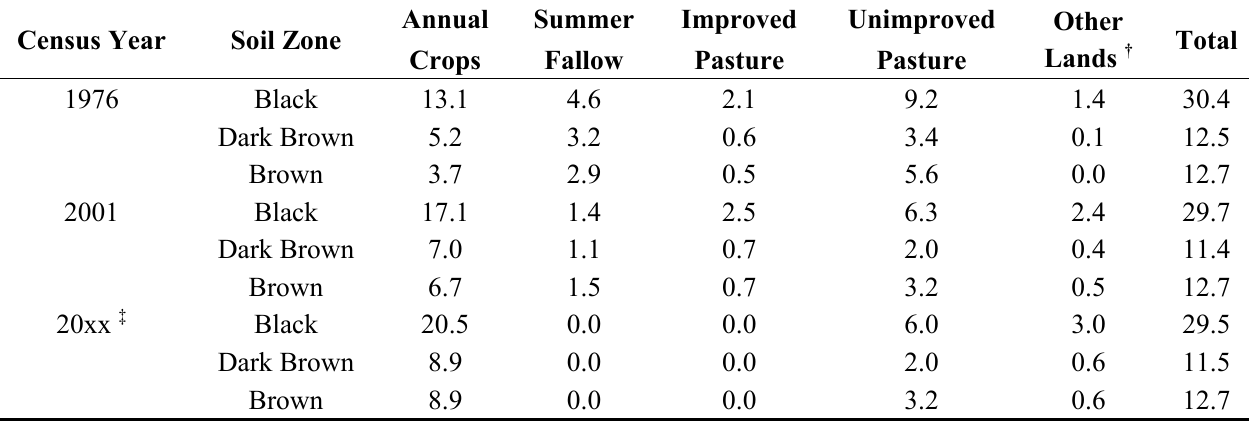
Table 2. Area (Mha) covered by annual crops, summerfallow, improved pasture, unimproved pasture and other lands in 1976, 2001 and 20xx for the three soil zones of the Canadian